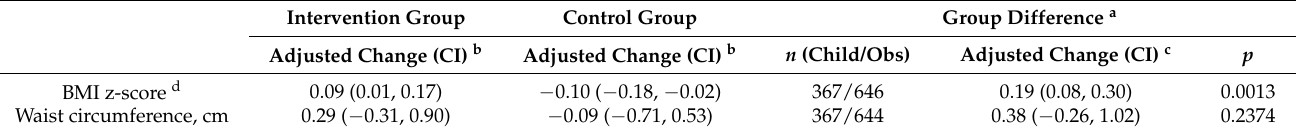
Table 3. Adjusted changes (95% confidence interval) for intervention and control and group difference a